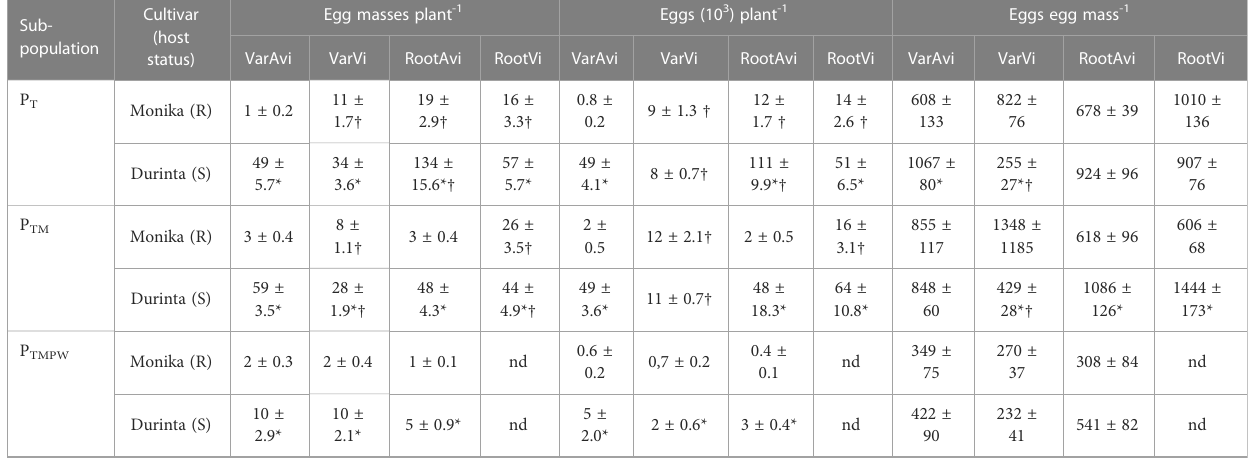
Cultivar Egg masses plant -1 Eggs (10 3 ) plant -1 Eggs egg mass -1 Sub- (host population VarAvi VarVi RootAvi RootVi VarAvi VarVi RootAvi RootVi VarAvi VarVi RootAvi RootVi status)